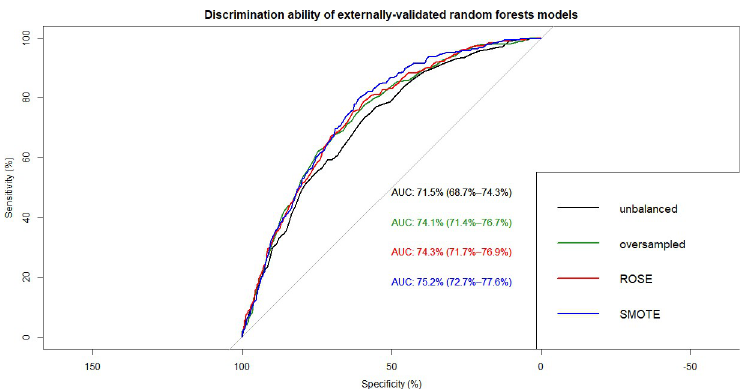
Fig 5. Overlapped ROC curves demonstrating predictive performance of random forests models on external validation data. Using unbalanced, original training data and re-structured with oversampling, ROSE and SMOTE